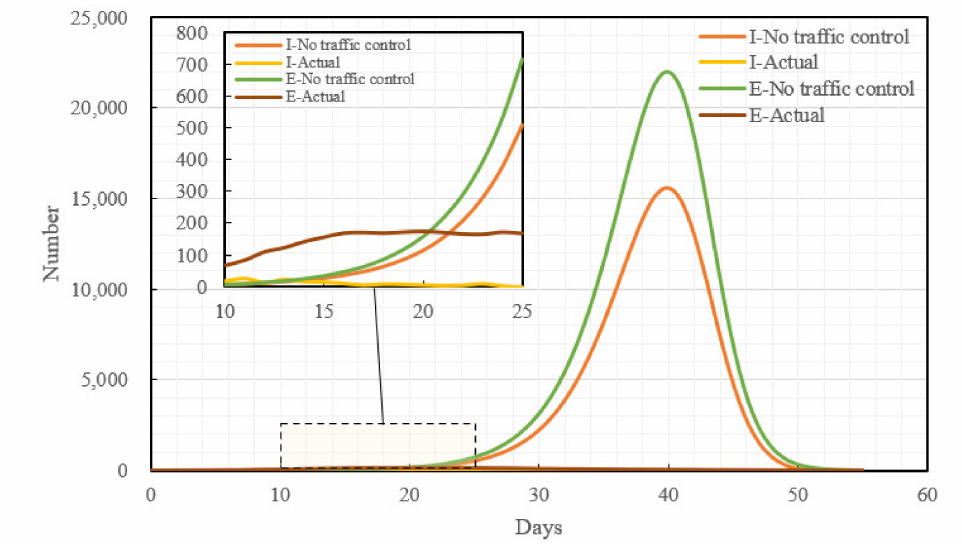
Figure 7. Comparison between the epidemic development trend without a traffic control policy and the actual epidemic development